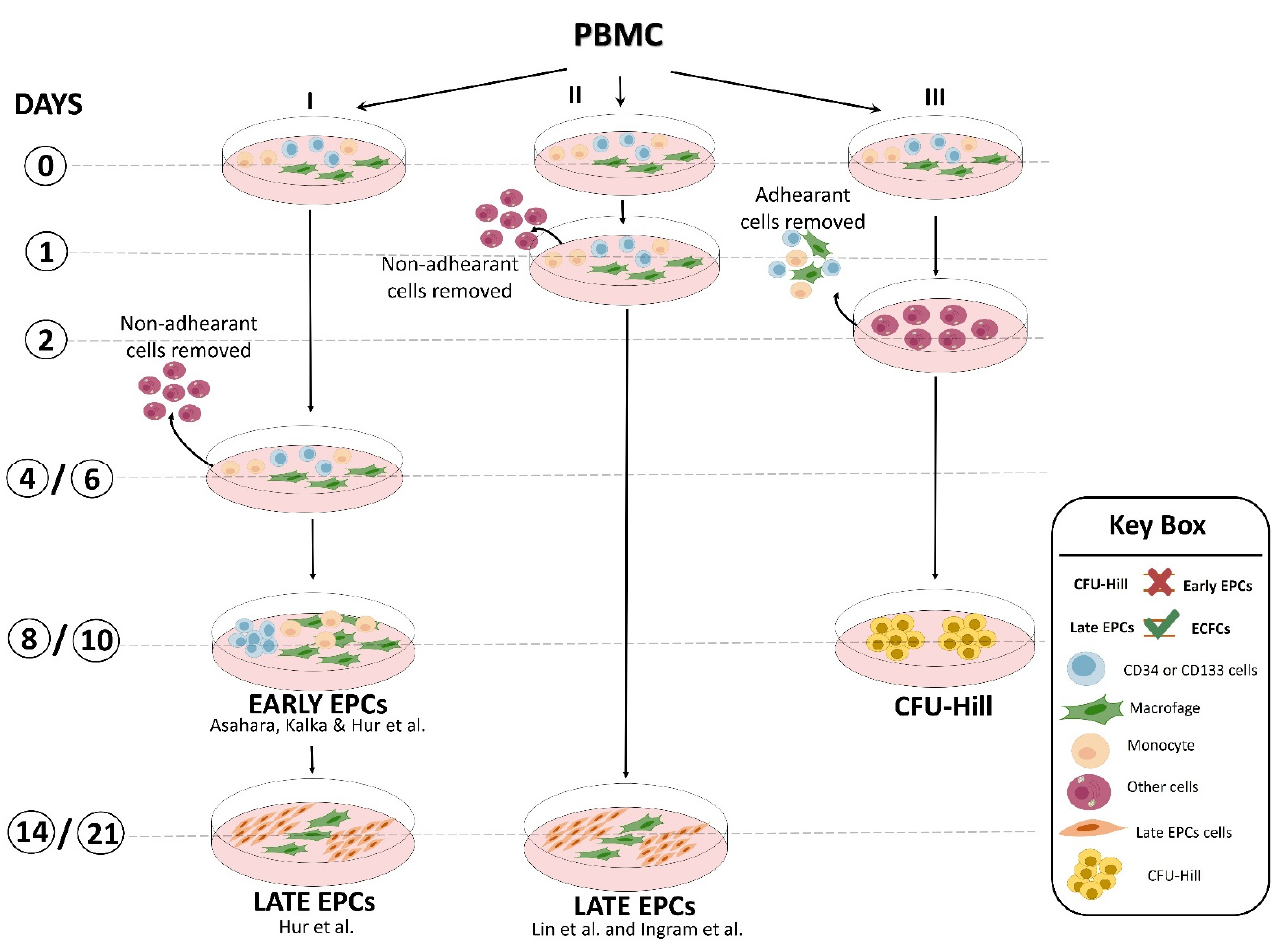
Figure 2. Representative scheme of culture methods developed by different laboratories to obtain “early EPCs”, “late EPCs” (named also ECFCs; endothelial colony-forming cells), and CFU-Hill.